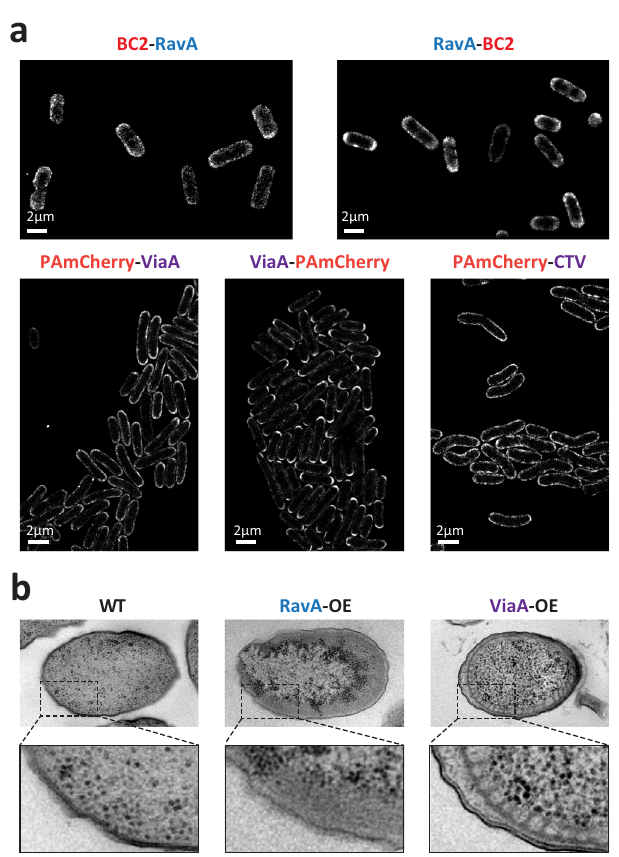
Fig. 3 | Imaging of overexpressed RavA and ViaA by super-resolution micro- scopy and cellular TEM. a Single molecule localisation microscopy imaging of E. coli cellsoverexpressing fl uorescentlylabeledRavAandViaAbySTORM(BC2-RavA, RavA-BC2) and PALM (PAmCherry-ViaA, ViaA-PAmCherry and PAmCherry-CTV). Eachexperimentwasperformedintriplicate,andonerepresentativeexperimentis shown. b Imaging of high pressure frozen, freeze-substituted and sectioned wild- type (WT) E. coli cells and E. coli cells overexpressing His-RavA (RavA-OE) or His- ViaA (ViaA-OE) by TEM. Each experiment was performed in triplicate, and one representative experiment is